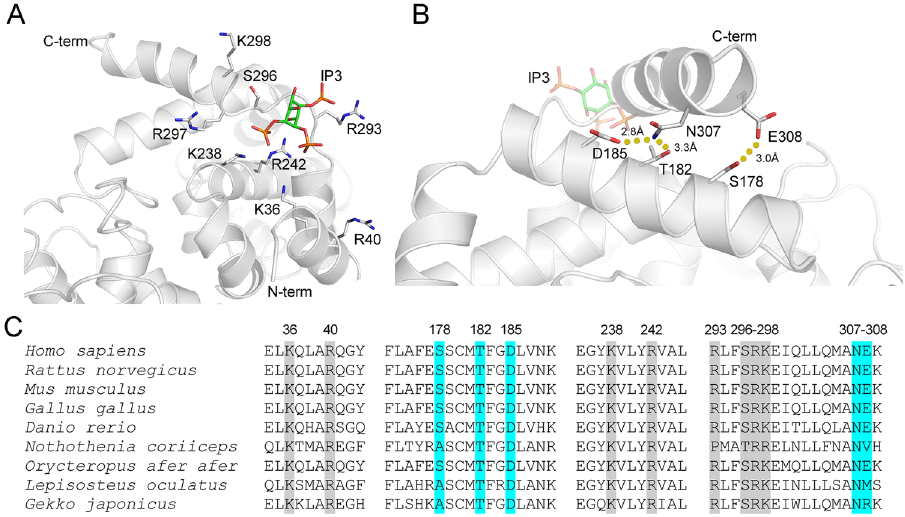
Figure 5. Structure of the human TBC domain from TBC1D24. ( A ) The homology model of TBC1D24 protein was superimposed over the IP 3 -Skywalker complex to obtain the structure of the human protein—IP 3 complex. The binding sites constitute of several, conserved, mostly positively charged amino acids. ( B ) The C-terminal helix is stabilized by polar interactions between N307, E308 with T182, D185 and S178. The latter two amino acids are changed to N and L, respectively, in patients with ADHL (this study). ( C ) Multiple sequence alignment of the human TBC domain from TBC1D24 and its homologs from selected organisms. Only regions comprising the binding site residues and two helices harboring S178, T182, D185, N307 and E308 are shown. D185 is conserved among Chordata, while S178 is present only in a subset of organisms, suggesting its auxiliary role in stabilizing the C-terminal helix. Residues highlighted in grey are involved in recognizing the membrane by the TBC domain, while residues highlighted in cyan are involved in the stabilization of conformation of the C-terminal helix of the TBC